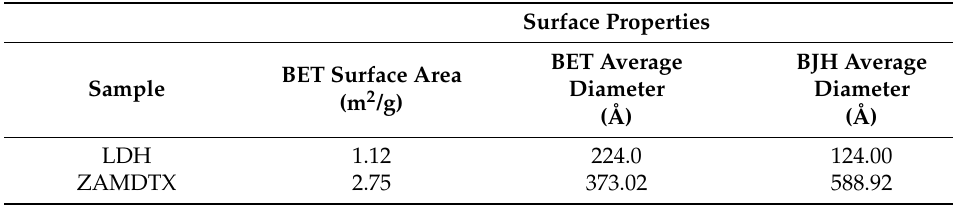
Table 2. Surface properties of LDH and ZAMDTX.